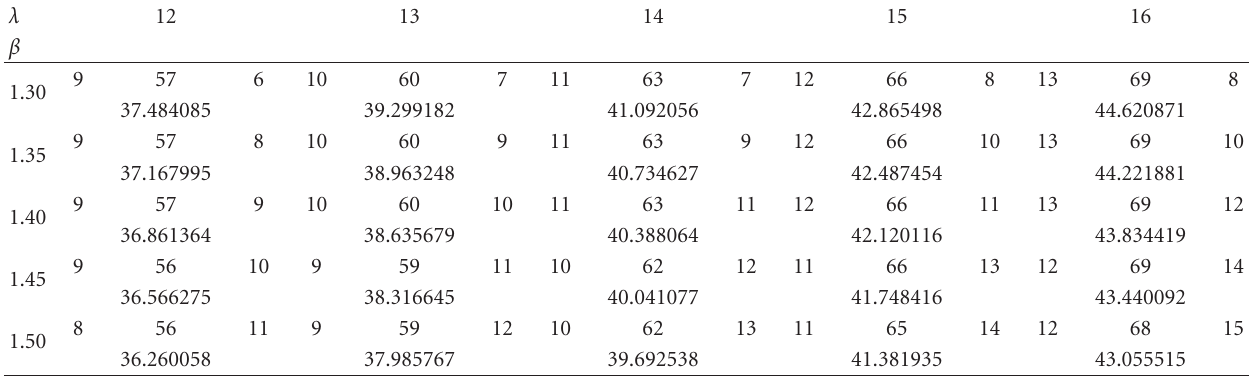
Table 3: Optimal values corresponding to various demand rates and the vacation time rates ( γ = 1 . 4, α = 4, μ = 4, p = 0 . 85).